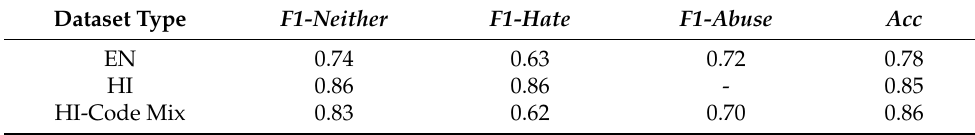
Table 5. Performance comparison of F1 scores and accuracy between classes for CNN-LSTM model. Dataset Type